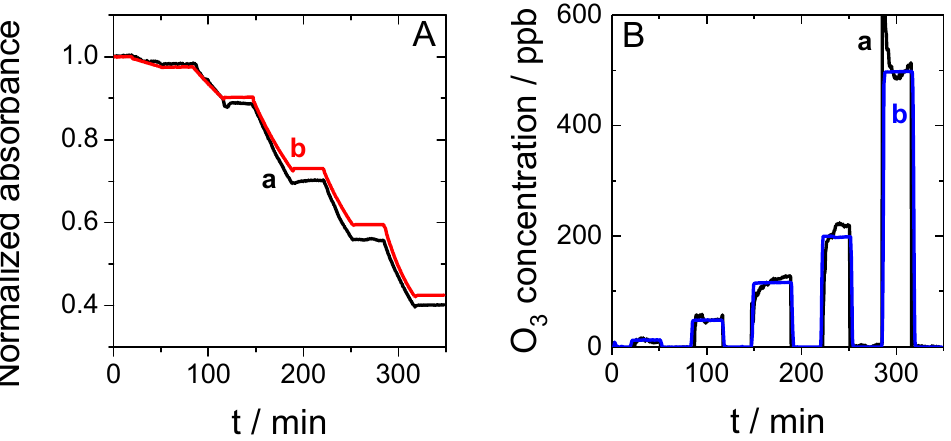
Figure 5. ( A ) Experimental (a, black) and model (b, red) curves showing the normalized absorbance as a function of time in the presence of increasing concentrations of O 3 from 12 to 500 ppb. ( B ) O 3 concentration measured as a function of time with the O 3 sensor (a, black) and controlled values given by a benchtop O 3 analyzer (b, blue).